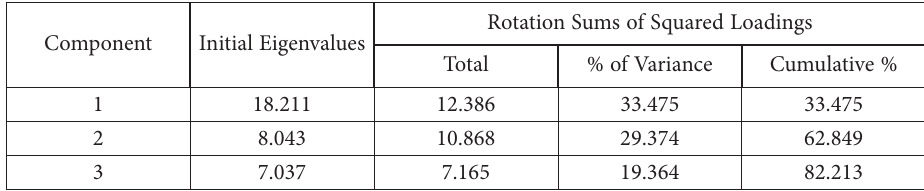
Table 2. Eigenvalues and total variance explained of the factorial axes (source: authors’ calculation) Rotation Sums of Squared Loadings Component Initial Eigenvalues Total % of